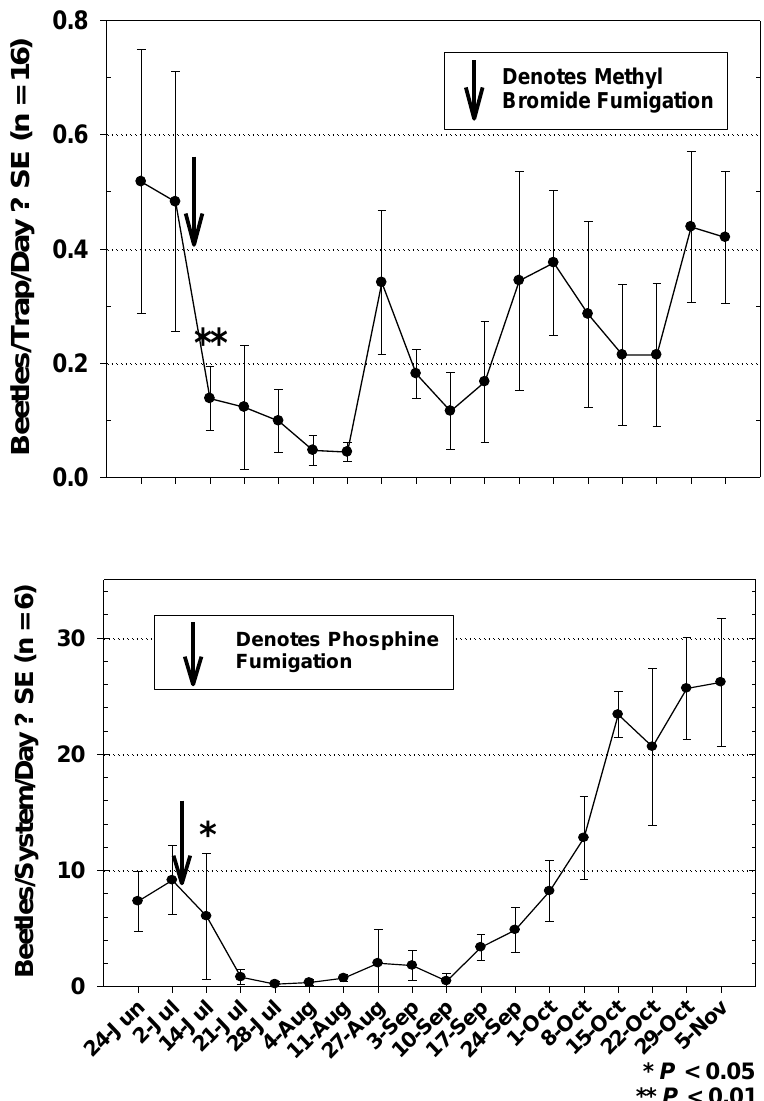
Figure 6. Trap capture throughout mill 1 and counts of T. castaneum from six load-out system tailings during Year 2. Trapping results are from weekly observations from 16 modified pitfall traps. Load-out counts are consolidated to correspond with trapping times and intervals. Arrows denote fumigation on 4 July. Beetle trap capture was significantly lower following methyl bromide fumigation ( t = 3.72; df = 11; p = 0.0047, shown with ** in the top graph). Beetles sampled from tail-over samples were significantly lower following phosphine fumigation ( t = 4.10; df = 4; p = 0.0262, shown with * in the bottom graph). Count data for t-tests were square root transformed.